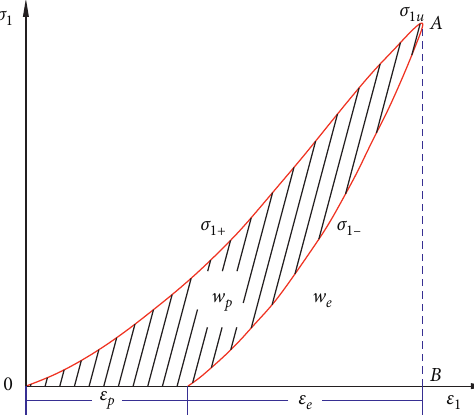
Figure 3: Internal strain energy of the coal